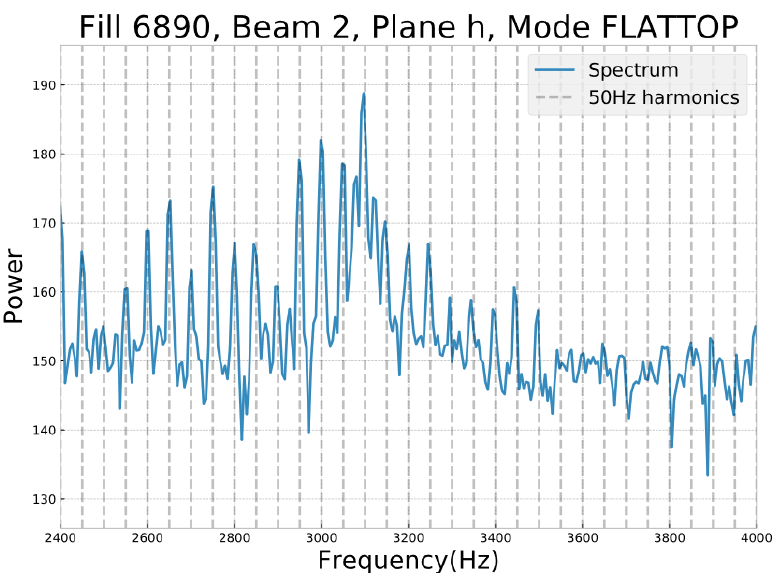
Figure 1. Example of 50 Hz harmonics present in the BBQ spectrum, obtained from LHC Fill 6890, Beam 2, horizontal plane in the FLATTOP beam